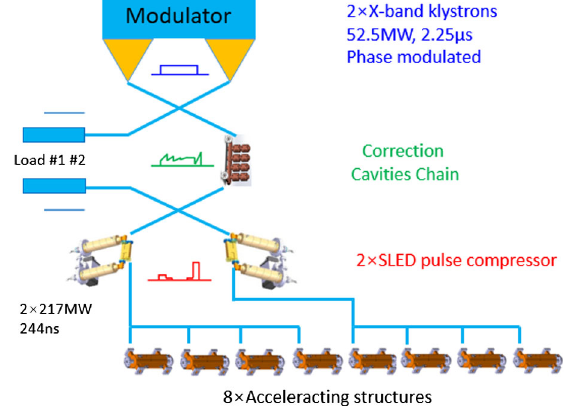
15. Conceptual design of an rf unit for a klystron-based CLIC main linac.